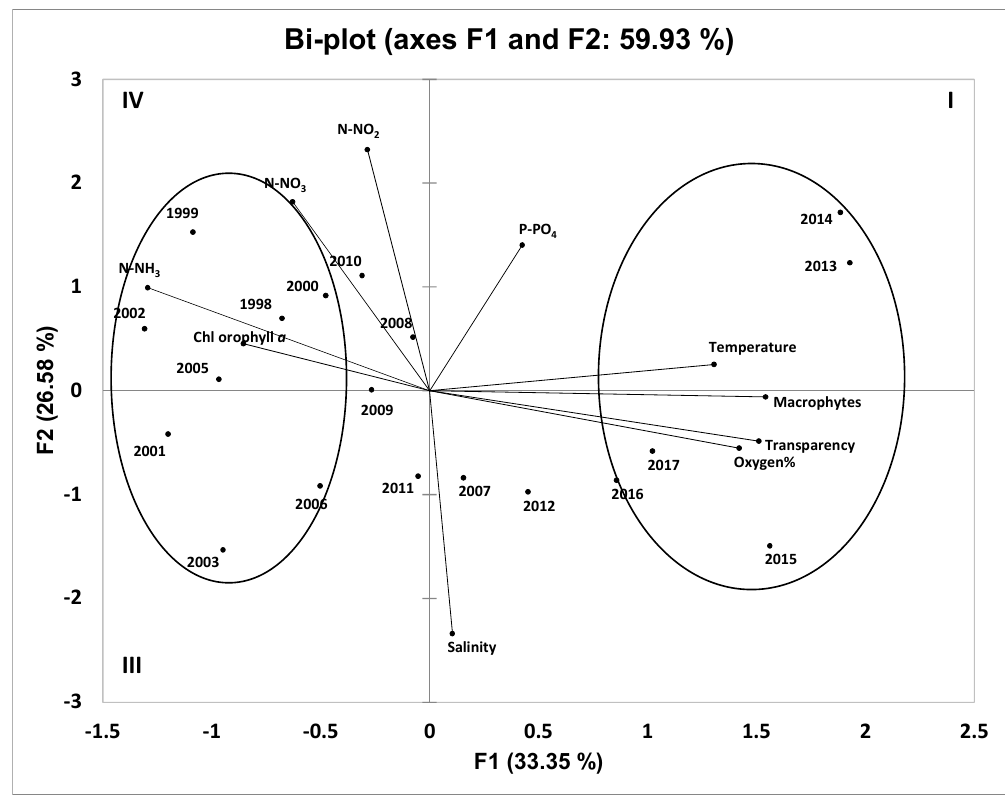
Figure 9. Principal component analysis (PCA, R-mode): the space is divided into four quadrants (I–IV) to facilitate interpretation; Cluster A = years 1998–2006; Cluster B = years 2013–2017. Table 4. T -test of hydrochemical parameter means, highlighting di ff erences between Cluster A and Cluster B evidenced by principal component